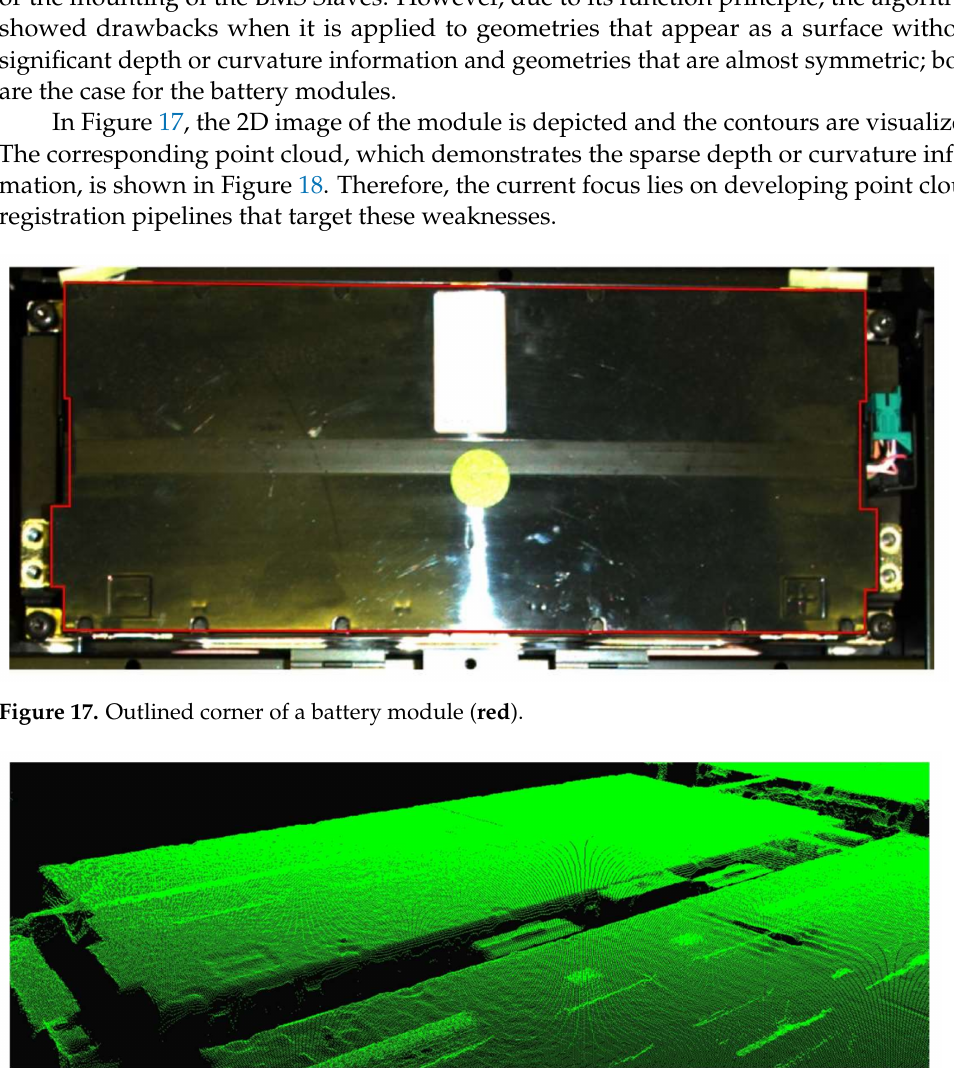
Figure 18. Point cloud of a battery module. Green dots are known data points, black areas resulting from lack of depth